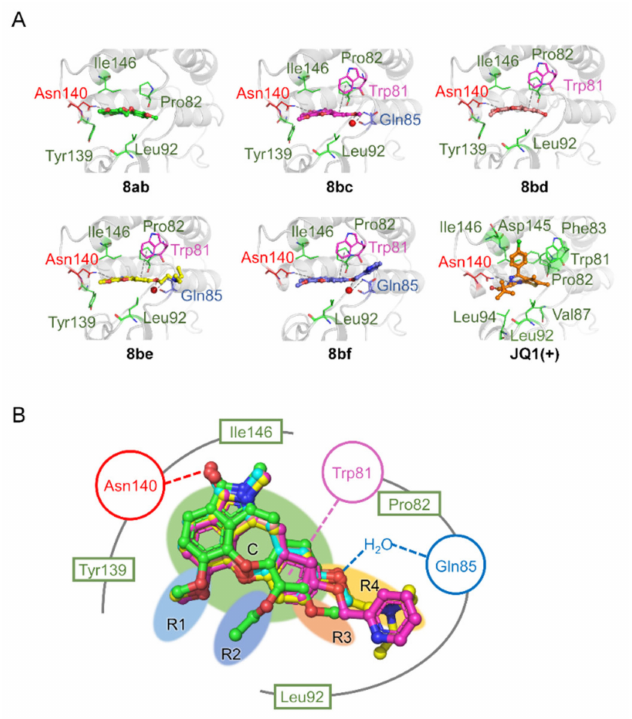
Figure 4. Binding modes of the five benzo[6,7]oxepino[4,3,2- cd ]isoindol-2(1 H )-one inhibitors and JQ-1. ( A ) Detailed view of binding modes of the five benzo[6,7]oxepino[4,3,2- cd ]isoindol-2(1 H )-one inhibitors ( 8ab , 8bc , 8bd , 8be , and 8bf ) and JQ-1 (PDB entry:3MXF). In each figure, the residues that interacted with each inhibitor are also presented. Residues interacting with the inhibitors are indicated in green, red, blue, and purple: Hydrophilic residues are indicated in green; the residue of Asn140 forms hydrogen bond is presented in red; the water bridge in ocean blue; π -stacking is presented by purple. ( B ) Overlapped views of the five benzo[6,7]oxepino[4,3,2- cd ]isoindol-2(1 H )-one inhibitors are presented along with the interactions between each inhibitor and protein residues. The core structure C of inhibitors and chemical moieties (R 1 –R 4 ) are